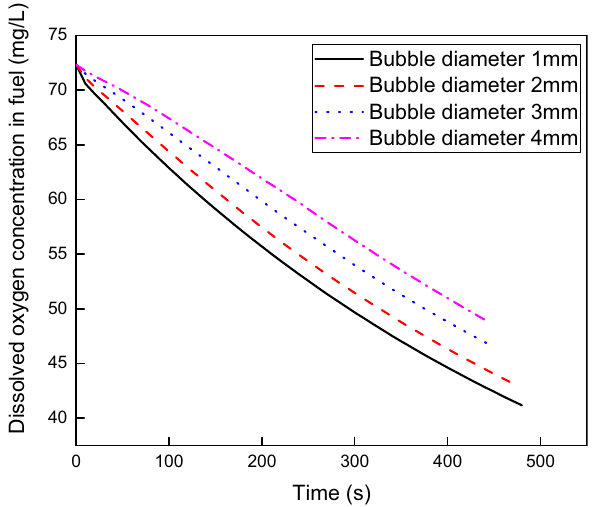
Figure 6. Dissolved oxygen concentration versus scrubbing time at various bubble diameters.